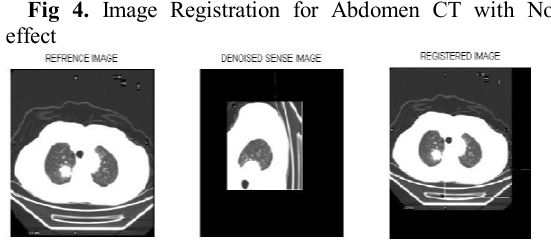
Fig 5. Image Registration for Abdomen CT with Denoise effect Horizontal movement: 55, Vertical movement: 51, Rotated angle: 90ᴼ